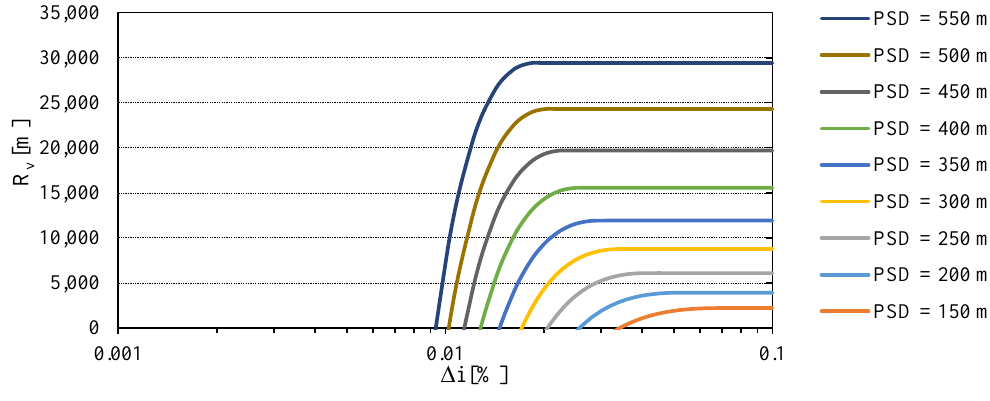
Figure 7. R v values (h 1 = 1.10 m and h 2(m) = 1.48 m).